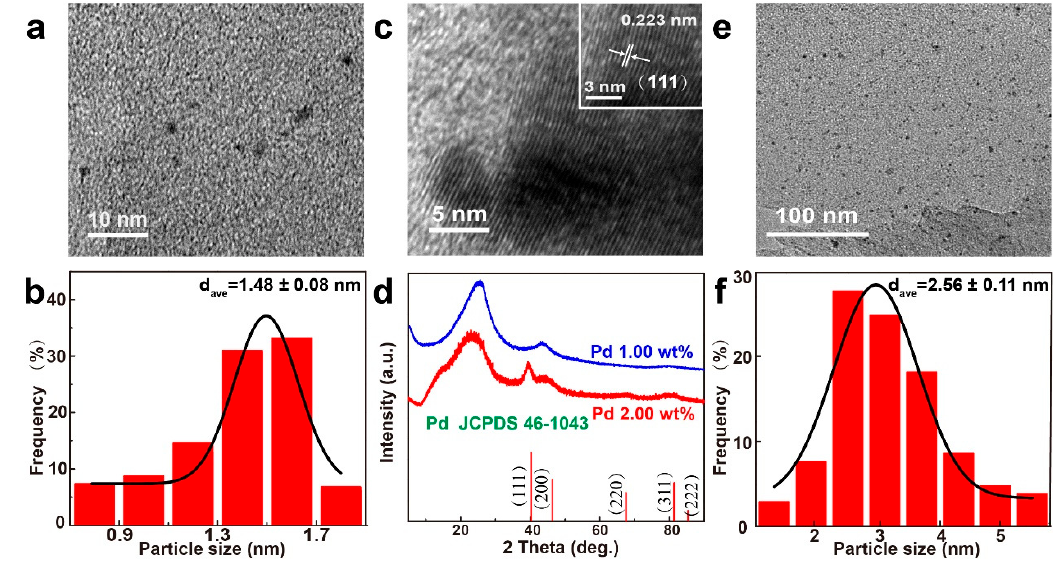
Figure 1. ( a ) TEM image, ( b ) Pd size distribution, ( c ) HRTEM image, and ( d ) XRD patterns of Pd/NPC with different loadings. ( e ) TEM image and ( f ) size distribution of Pd/NPC after recycling test.